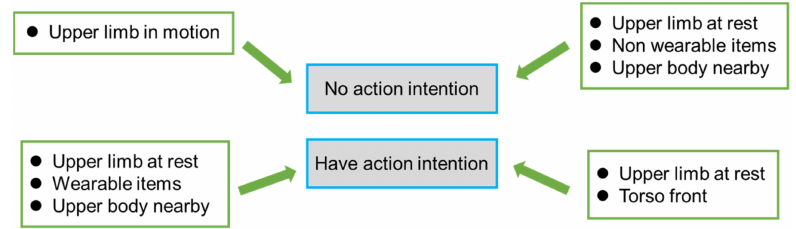
Figure 6. Upper limb action intention recognition